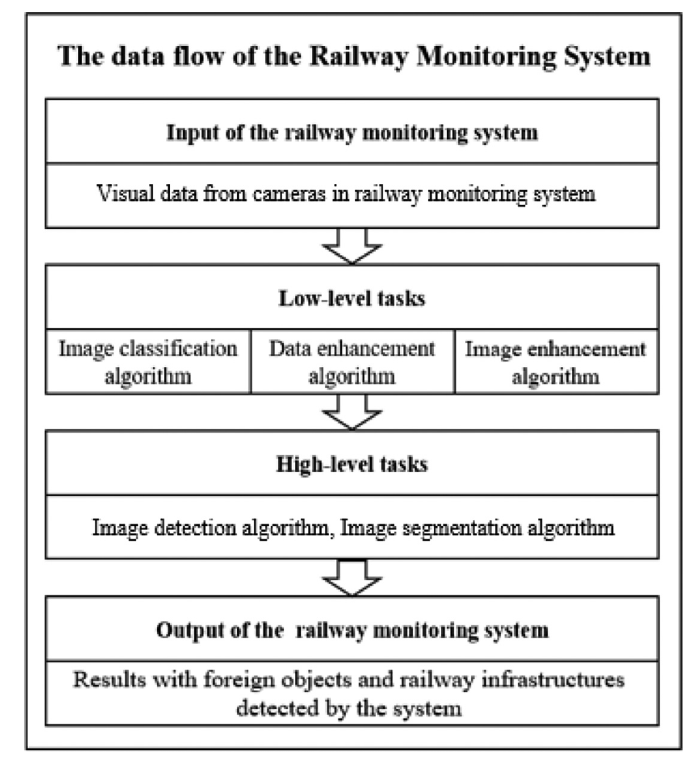
Figure 1. Data fl ow of railway monitoring